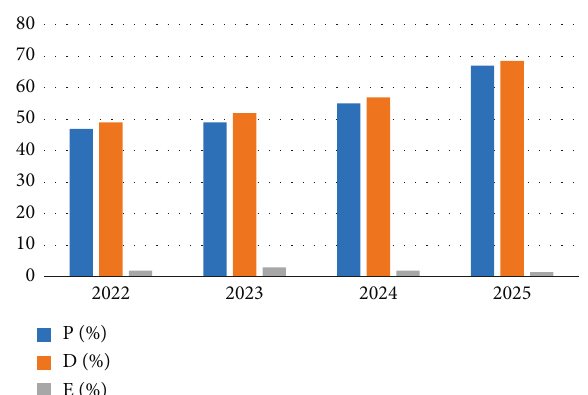
Figure 11: Test data for future